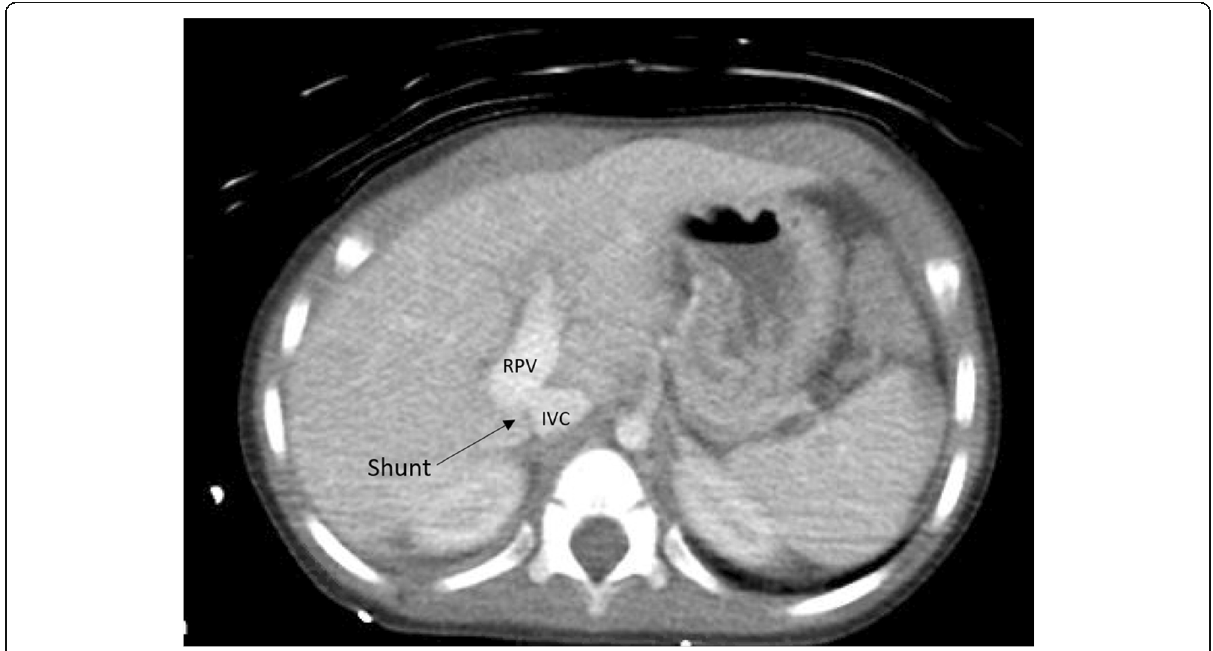
Fig. 1 Pre-procedure imaging: Axial CT image demonstrating a portosystemic shunt (black arrow) between the right portal vein (RPV) and inferior vena cava (IVC)